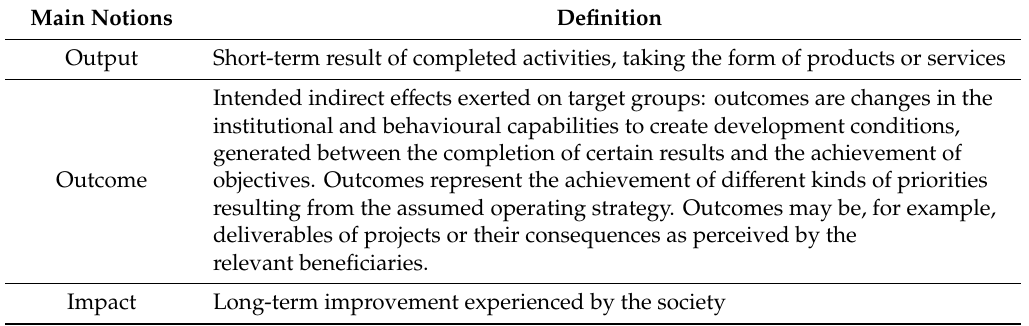
Table 1. Interpretation of main notions used in the sphere of performance